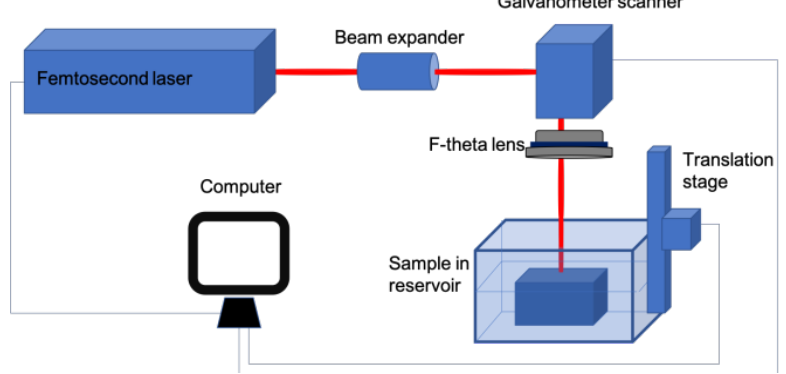
Figure 1. Experimental setup of a femtosecond laser processing